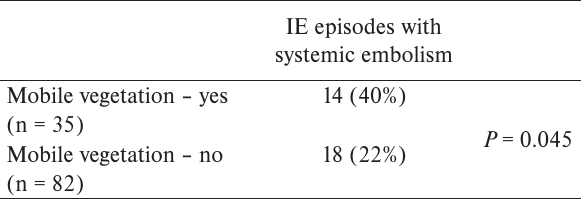
Table 3. Relationship between vegetation mobility and systemic